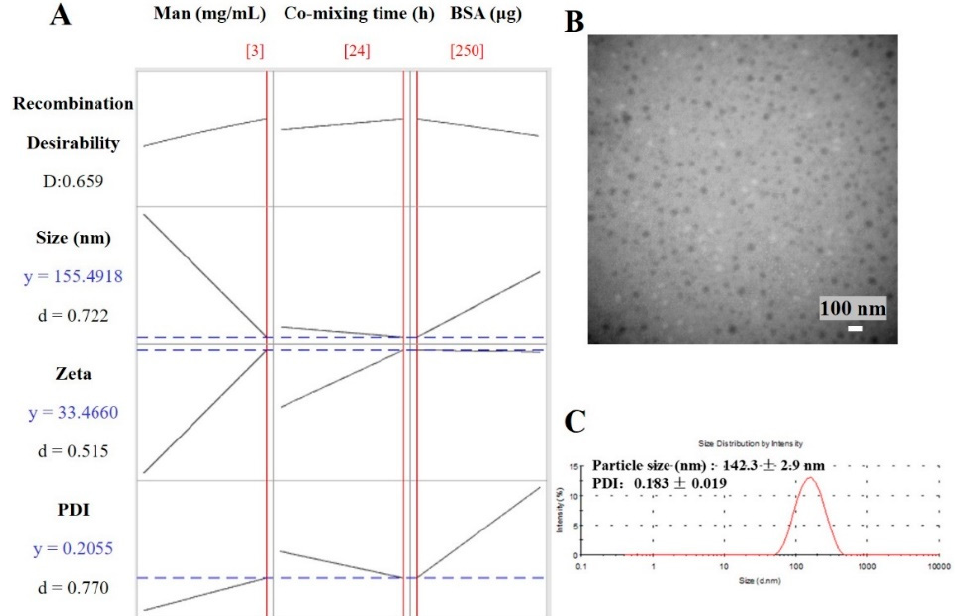
Figure 4. ( A ) Calculated optimization plot (red data/red current line) using the Minitab 10